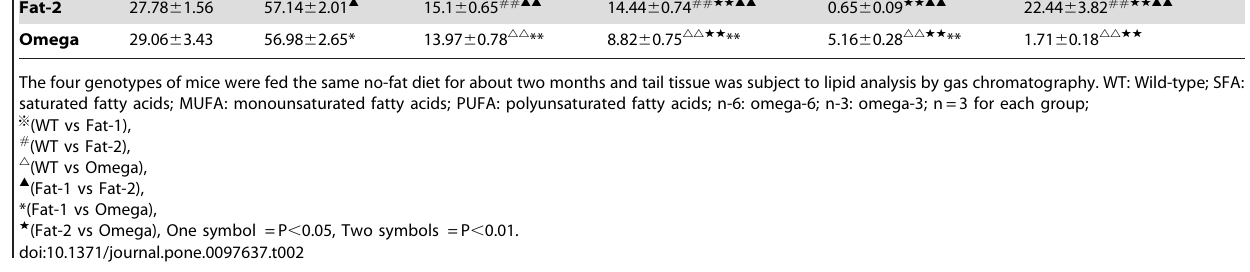
(WT vs Fat-1), # (WT vs Fat-2), g (WT vs Omega), m (Fat-1 vs Fat-2), *(Fat-1 vs Omega), w (Fat-2 vs Omega), One symbol =P , 0.05, Two symbols =P ,